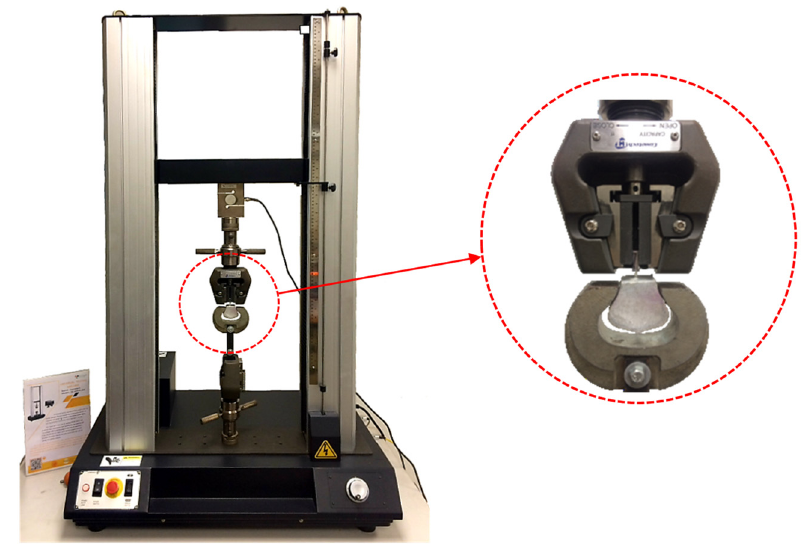
Figure 2. Single fiber pullout test setup .